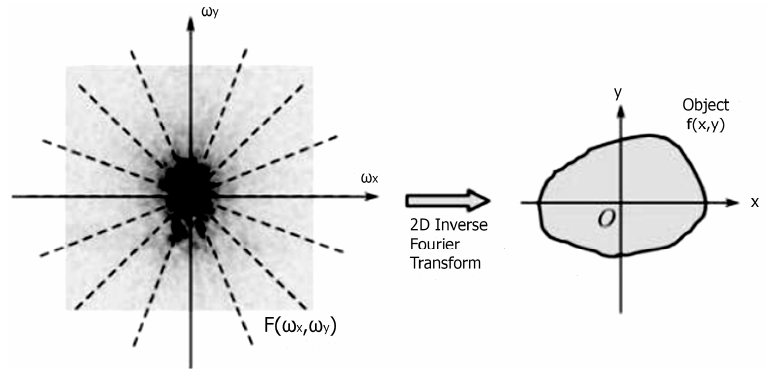
Figure 5. Image reconstruction using the Fourier intersection theorem.